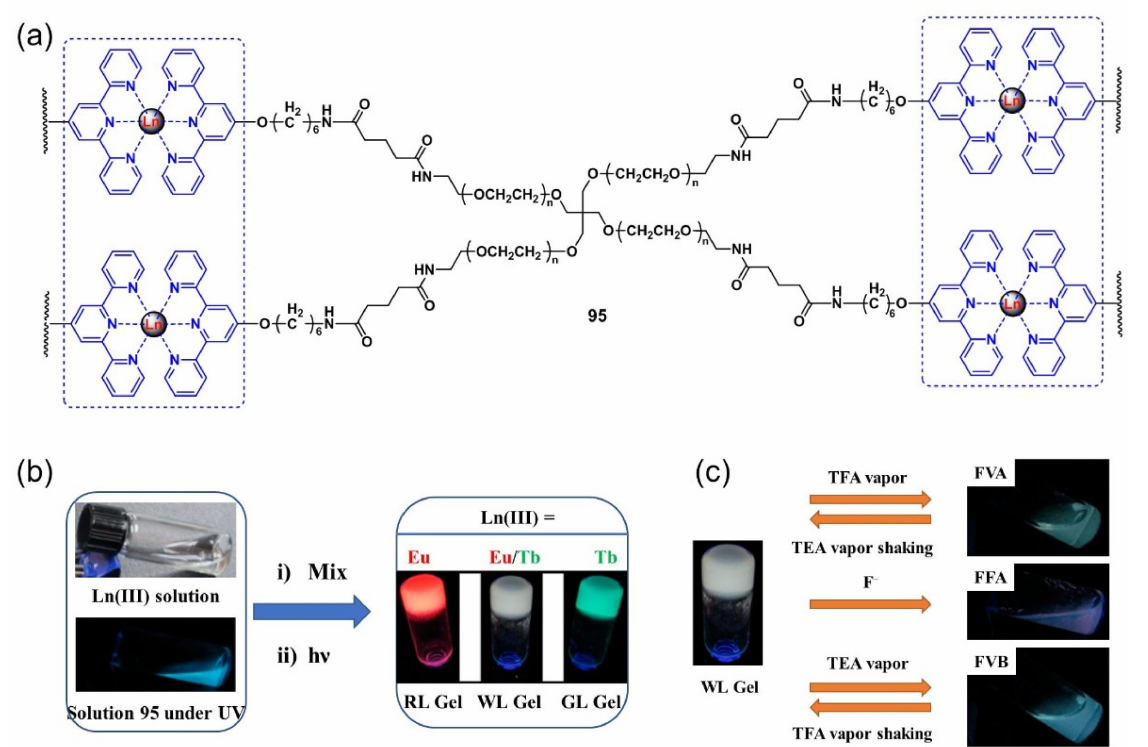
Figure 40. ( a ) Chemical structure of polymer 95 cross-linked via Ln − Terpy coordination. ( b ) Schematic representation of Ln(III) coordination-based luminescent metallogels under UV